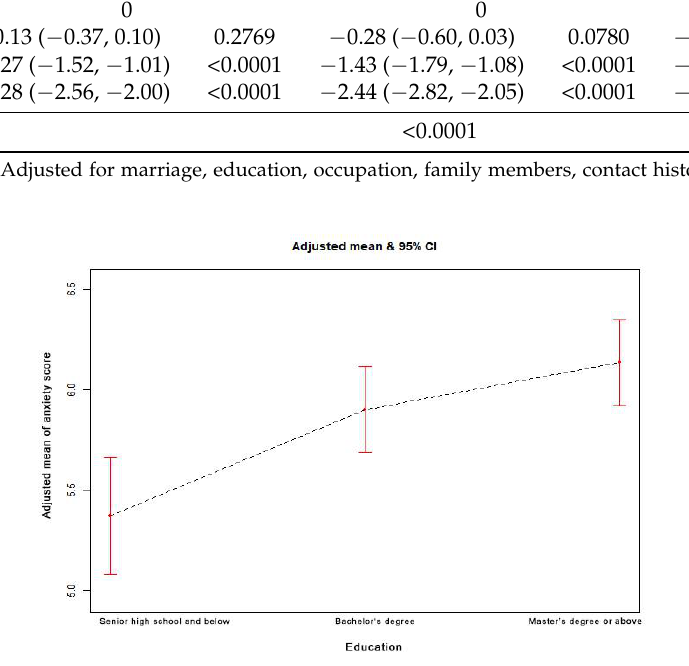
Figure A1. The dose–response relationship between education and the anxiety score. (Notes: Generalized additive models; Outcome variable: anxiety score; Exposure variable: education; Adjustment variables: age, sex, marriage, occupation, family members, contact history).